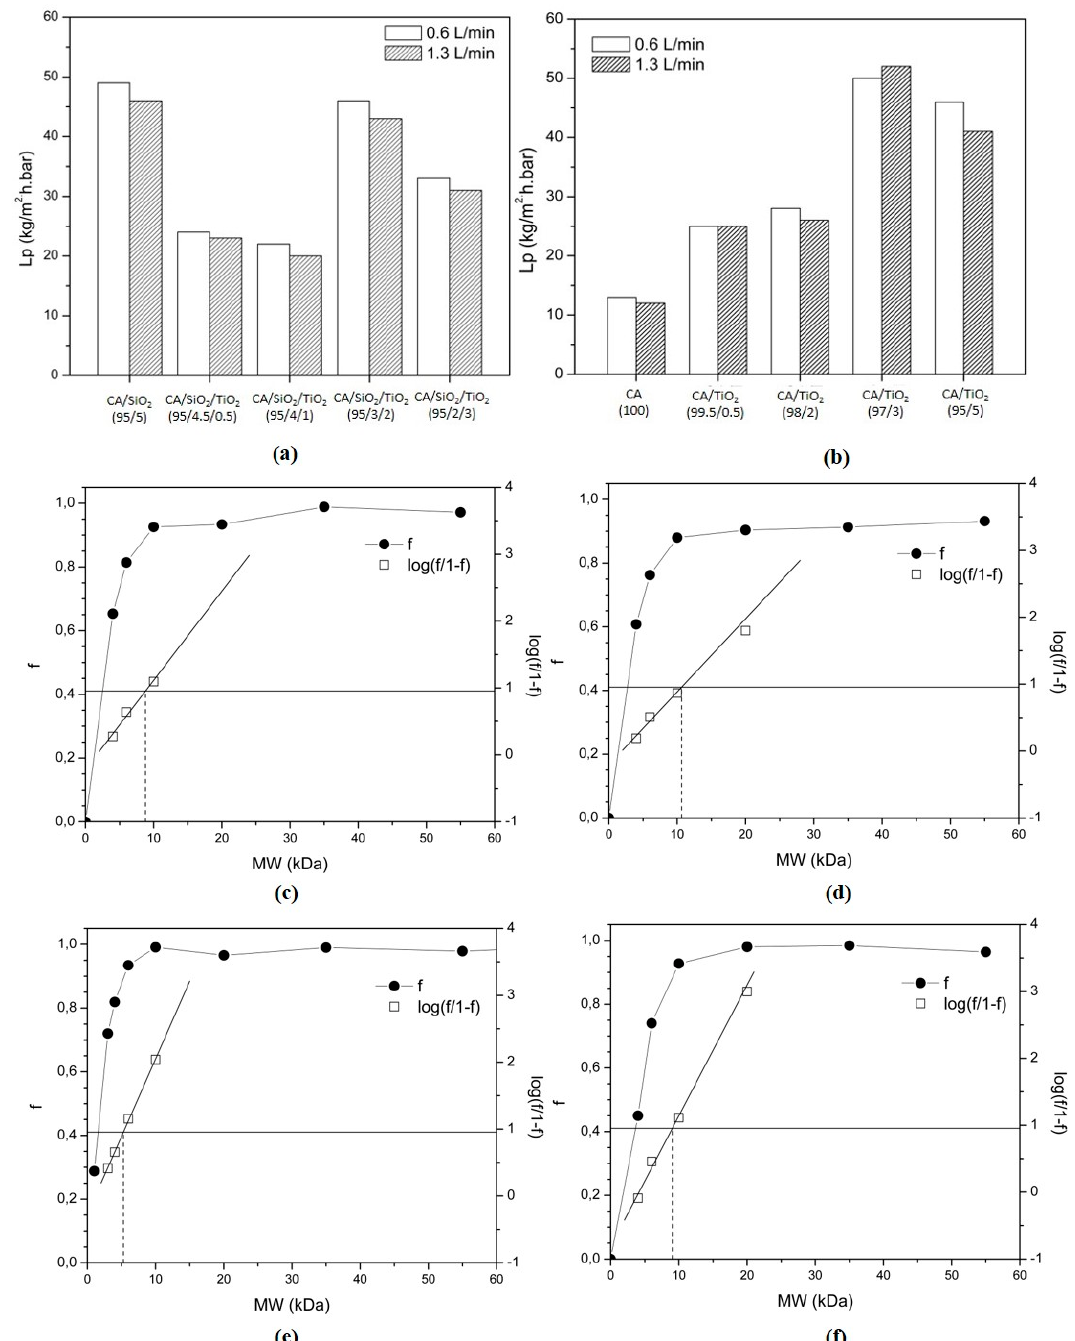
Figure 8. ( a , b ) Hydraulic permeability ( Lp ) for the membranes in series 1 ( a ) and 2 ( b ) determined at TMPs 0.5, 1.0, 1.5, 2.0, 2.5, and 3.0 bar and feed flow rate 0.6 L / min (white), and 1.3 L / min (hatched). ( c – f ) Rejection curves to PEGs of increasing MW and determination of the MWCO of the membranes in series 1 ( c , d ) and series 2 ( e , f ); ( c ) CA / SiO 2 (95:5) membrane: f vs. MW curve (black circle) log(f / 1 − f)